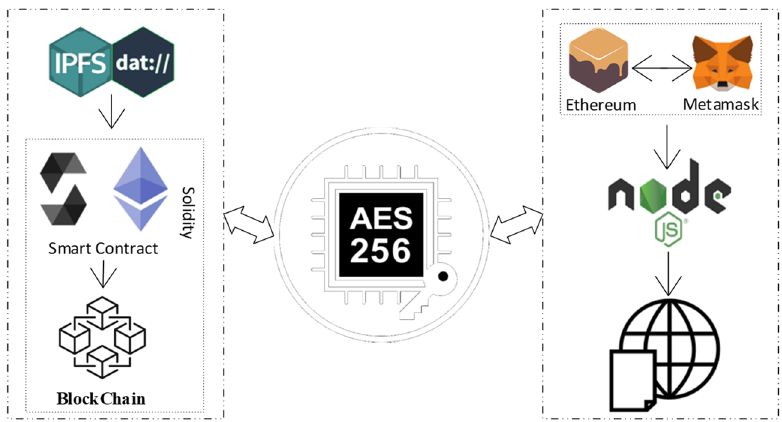
Figure 6. A description of the technologies and tools used for system implementation.